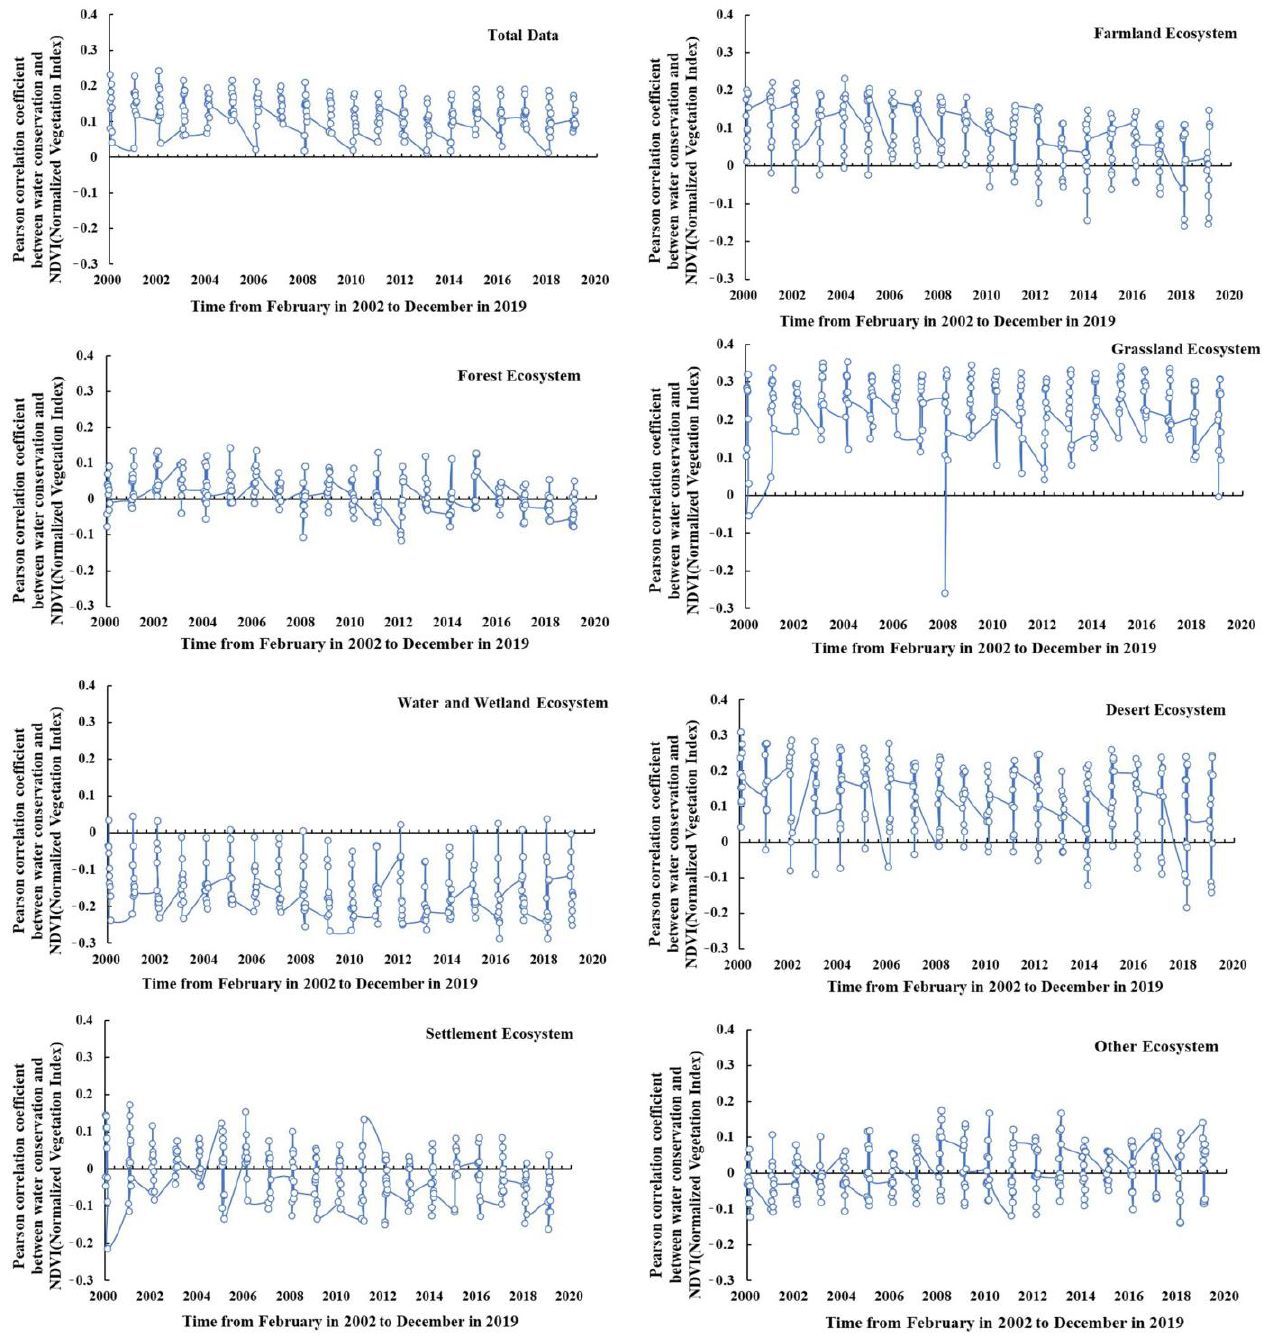
Figure 4. The Pearson correlation coefficients between water conservation and normalized difference vegetation index (NDVI) time series data from 2000 to 2019 for all data and for seven ecosystem types.